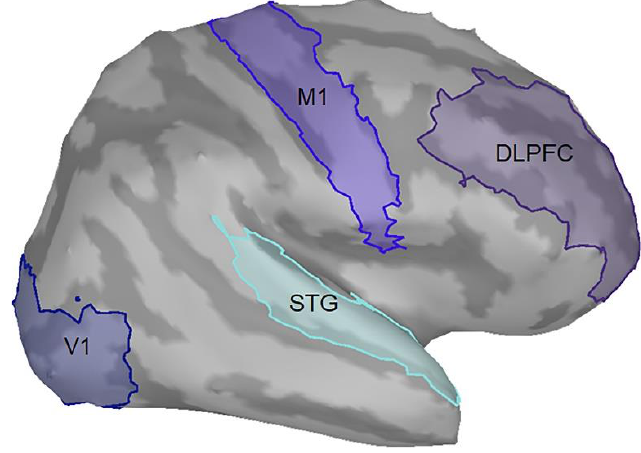
Figure 2. Selection of regions of interest on the ICBM152 cortical surface. DLPFC, dorsolateral prefrontal cortex; V1, primary visual cortex; M1, primary motor cortex; STG, superior temporal gyrus.